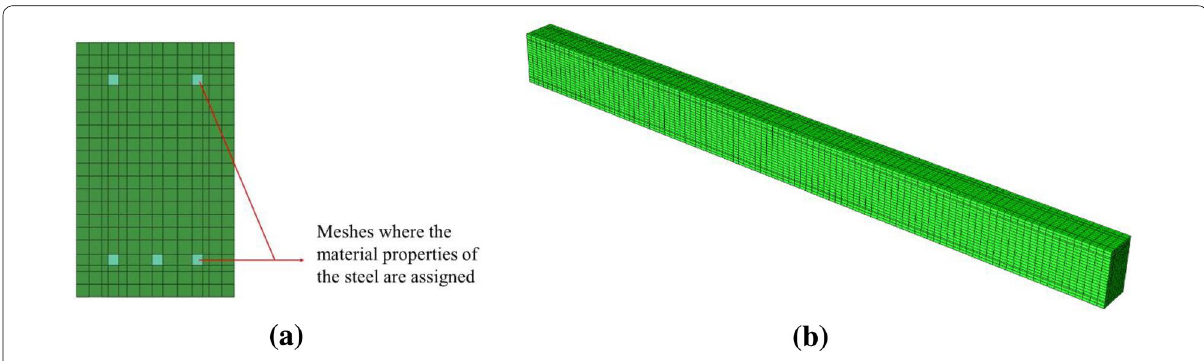
Fig. 7 FE model. a Cross sectional view and b 3D view.